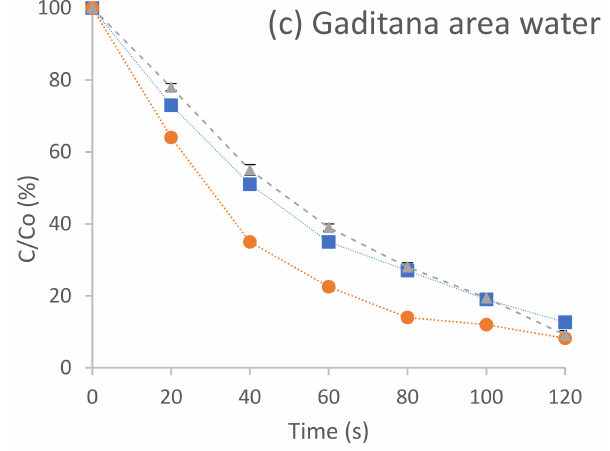
Figure 3. Degradation of the pesticide terbuthylazine in ultrapure water ( a ), groundwater ( b ) and water from the Gaditana area ( c ) by ultraviolet radiation ( (cid:4) ), hydrogen peroxide photolysis ( • ) and Photo-Fenton ( (cid:78) ) in a semi-continuous